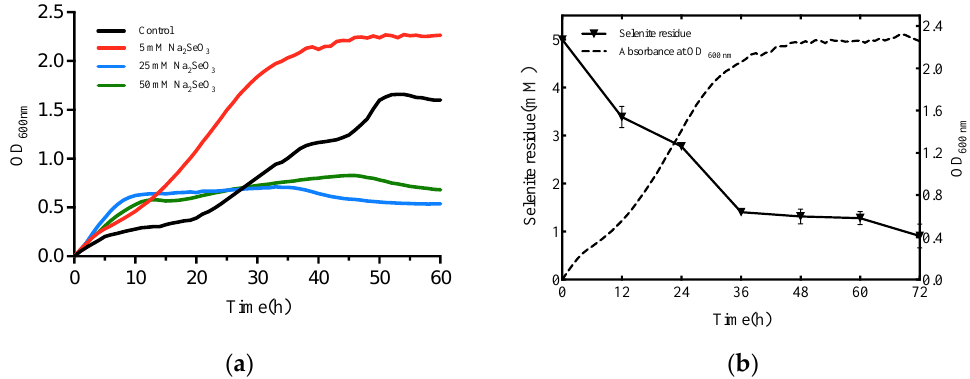
Figure 2. Growth curve, selenite reduction of B. subtilis T5 in the presence of selenite (5 mM). ( a ) Growth curve of strain T5 in the different concentrations of selenite (0, 5, 25, 50 mM); ( b ) Selenite reduction of B . subtilis T5 in the presence of selenite (5 mM).